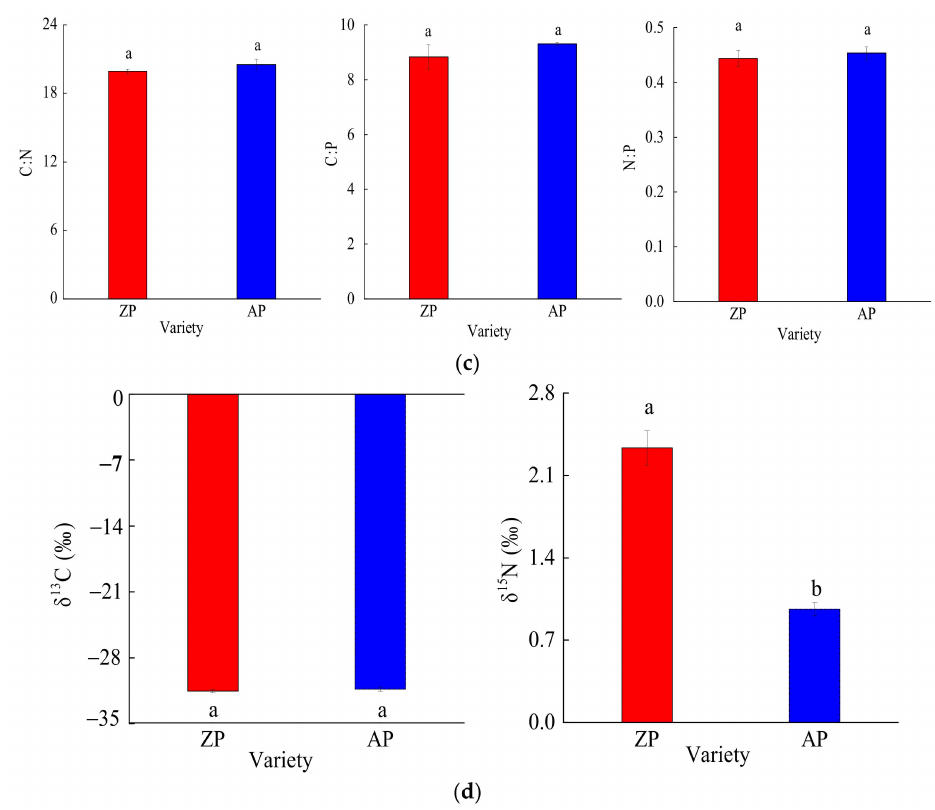
Figure 1. Leaf functional traits of Zanthoxylum planispinum ‘dintanensis’ and Zanthoxylum armatum ‘novemfolius’. Different letters represent significant differences at the level of p < 0.05. ( a ) The comparison of the leaf structural traits between Zanthoxylum planispinum ‘dintanensis’ and Zanthoxy- lum armatum ‘novemfolius’. ( b ) The comparison of the leaf element traits between Zanthoxylum planispinum ‘dintanensis’ and Zanthoxylum armatum ‘novemfolius’. ( c ) The comparison of the leaf element stoichiometry between Zanthoxylum planispinum ‘dintanensis’ and Zanthoxylum armatum ‘novemfolius’. ( d ) The comparison of the leaf physiological traits between Zanthoxylum planispinum ‘dintanensis’ and Zanthoxylum armatum